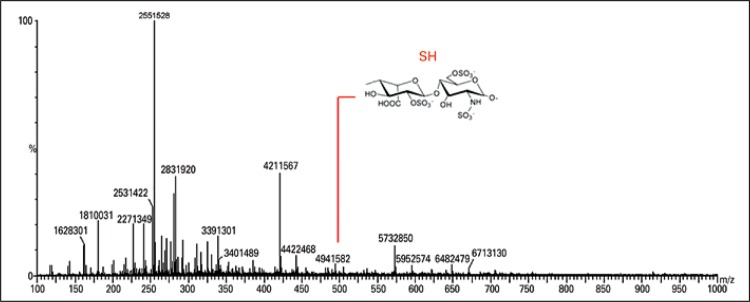
Espectroscopia de massa para identificar oligossacarídeos de sulfato de heparan. Oligossacarídeos e dissacarídeos de sulfato de heparan após digestão com heparitinase I e II. Os produtos foram comparados com o padrão de produtos de sulfato de heparan